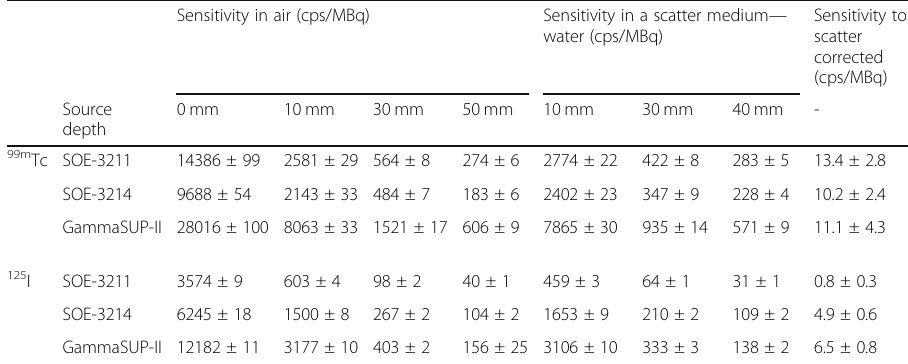
Table 3 Sensitivity in air, sensitivity in a scatter medium and sensitivity to scatter corrected from sensitivity through side shielding in air for the three probes Sensitivity in air (cps/MBq) Sensitivity in a scatter medium —